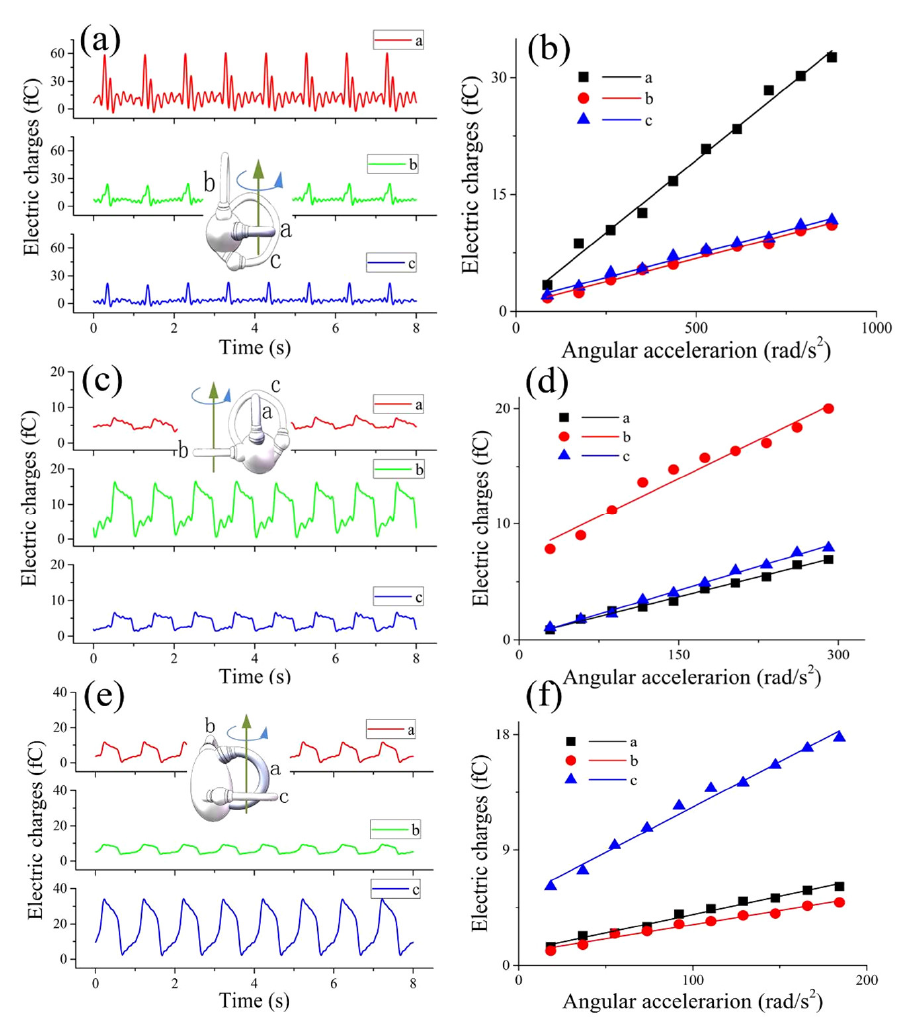
Figure 6. Experimental results for sensing angular acceleration using the 3-BSC: ( a ) the 3-BSC sensed impact angular displacement; ( b ) the relationship between the amplitude of impact angular acceleration and the amplitude of output electric charges of the 3-BSC; ( c ) the 3-BSC sensed square angular displacement; ( d ) the relationship between the amplitude of square wave angular acceleration and the amplitude of output electric charges of the 3-BSC; ( e ) the 3-BSC sensed sinusoidal angular displacement; ( f ) the relationship between the amplitude of sinusoidal angular acceleration and the amplitude of output electric charges of the 3-BSC.